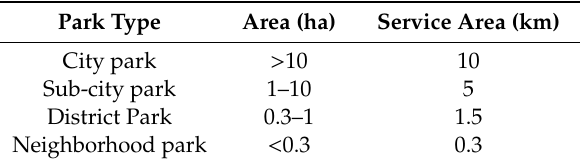
Table 1. Urban park typology in Addis